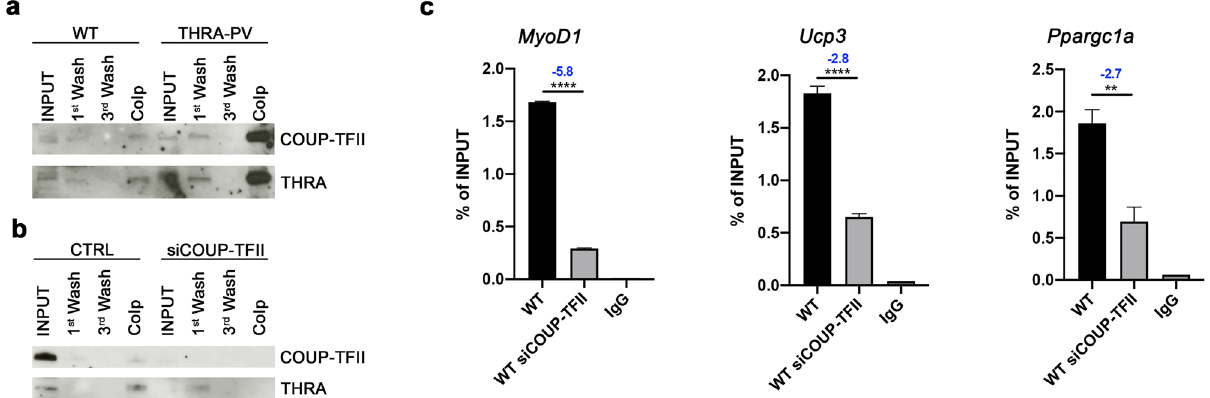
Figure 2. COUP-TFII interacts with THRA and modulates its binding to TREs. ( a ) Co-immunoprecipitation of COUP-TFII and THRA in nuclear proteins from skeletal muscle of WT and THRA-PV mice; COUP-TFII was used as bait. ( b ) Co-immunoprecipitation of COUP-TFII and THRA in nuclear proteins isolated from C2C12 myoblast (CTRL) and C2C12 myoblasts after COUP-TFII silencing (siCOUP-TFII); COUP-TFII was used as bait. ‘INPUT’ is the total nuclear fraction, ‘1st wash’ is the negative fraction after precipitation, ‘3rd wash’ is the last wash, ‘CoIP’ is the positive fraction after 3 washes. ( c ) ChIP- qPCR analysis of the recruitment of THRA to the TRE in the MyoD1, Ucp3 and Ppargc1a promoter regions. Bar graph showed the enrichment of DNA fragments pulled down by THRA antibody. Data are shown as mean ± SEM. Two-tailed Student’s t test; ** p < 0.01, **** p < 0.0001. Fold Change is